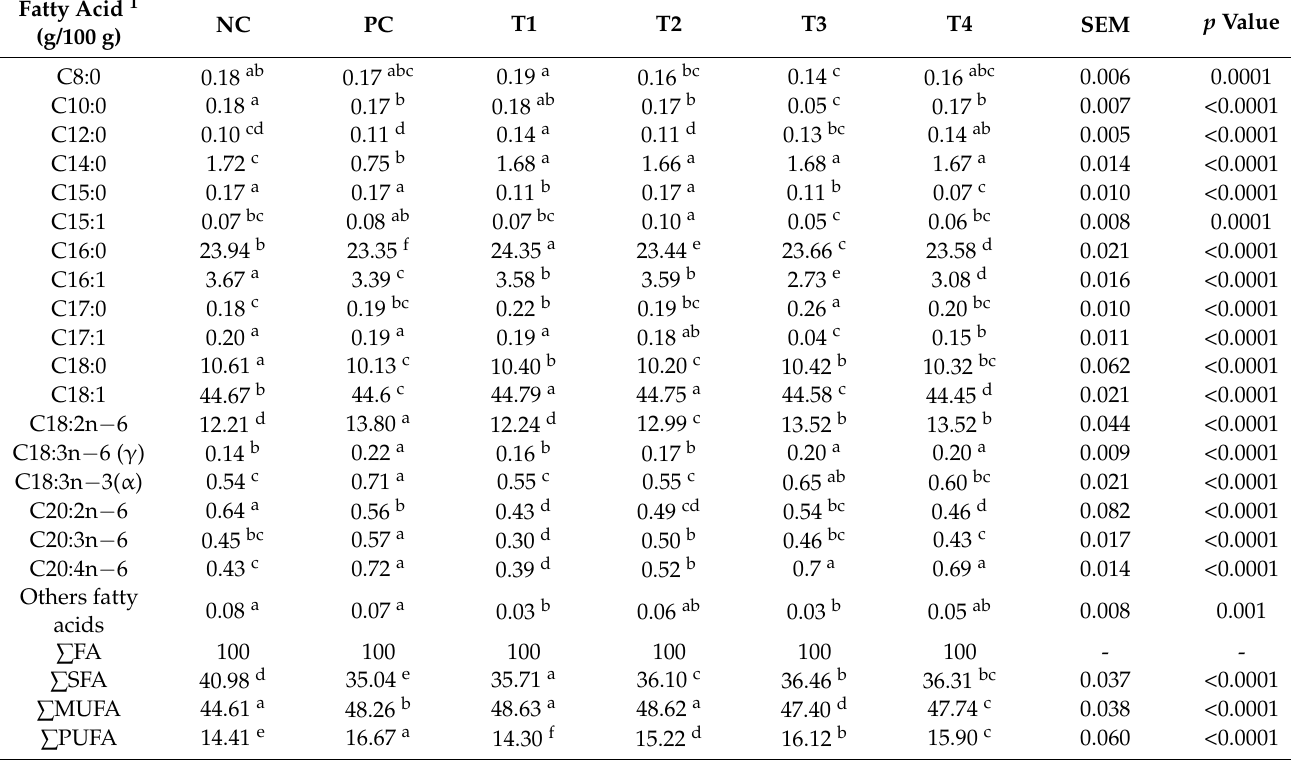
Table 3. Fatty acid profile of pork mince with different treatments after 9 days of